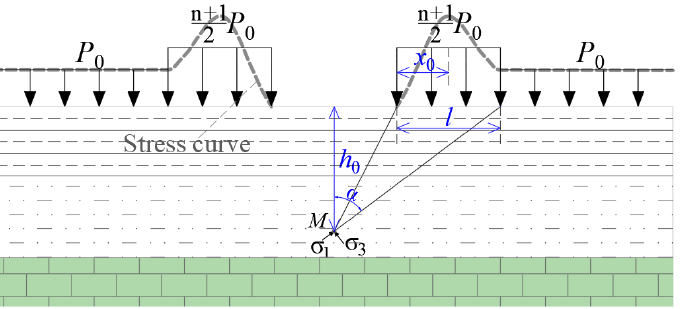
Figure 2. The sketch map of floor load along rock strata oblique section.